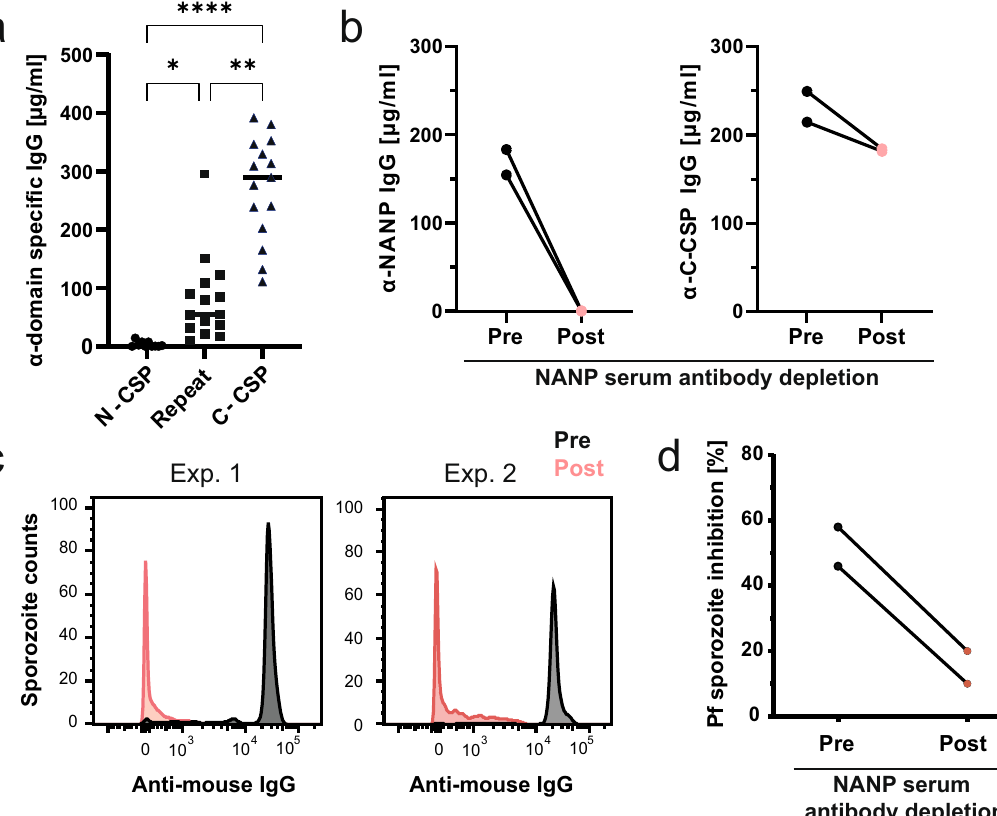
Fig. 1 The C-CSP of recombinant PfCSP is highly immunogenic but fails to induce protective serum-antibody responses in mice. a C57BL/ 6J mice were immunized with FL-PfCSP at day 0, 21 and 42 adjuvanted with SAS. The serum IgG concentration against the indicated PfCSP domains was determined 7 days after the last immunization. Dots represent data from individual mice. Pooled data of three independent experiments with 5 mice per group are shown. Black horizontal lines indicate arithmetic means. Statistically signi fi cant differences were calculated by Kruskal – Wallis test with Dunn ’ s correction (* P < 0.05; ** P < 0.01; **** P < 0.0001). b Sera, collected 7 days after the last immunization, from 5 mice of the same experimental group were pooled and NANP-reactive antibodies were depleted. The IgG concentration of NANP and C-CSP reactive antibodies was determined before (pre) and after (post) depletion. Dots represent independent experiments. c Binding pro fi le to Pf sporozoites of the pooled sera described in ( b ) diluted 1:100. Gating on Pf sporozoites is shown in Supplementary Fig. 1. d Capacity of the pooled sera described in ( c ) to inhibit the hepatocyte traversal activity of Pf sporozoites in vitro. Dots represent independent traversal assay experiments. Gating strategy for Pf traversal analysis is shown in Supplementary Fig.